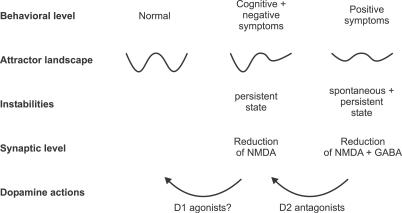
Summary of the Attractor Hypothesis of Schizophrenic Symptoms and the Simulation ResultsThe first basin (from the left) in each energy landscape is the spontaneous state, and the second basin is the persistent attractor state. The vertical axis of each landscape is the energy potential. See text for simulation results.